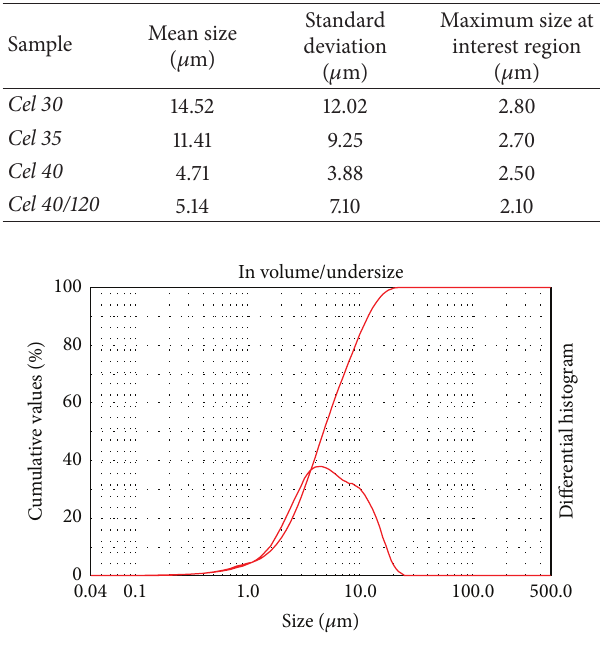
Figure 4: Typical result of the particle size analysis ( Cel 40